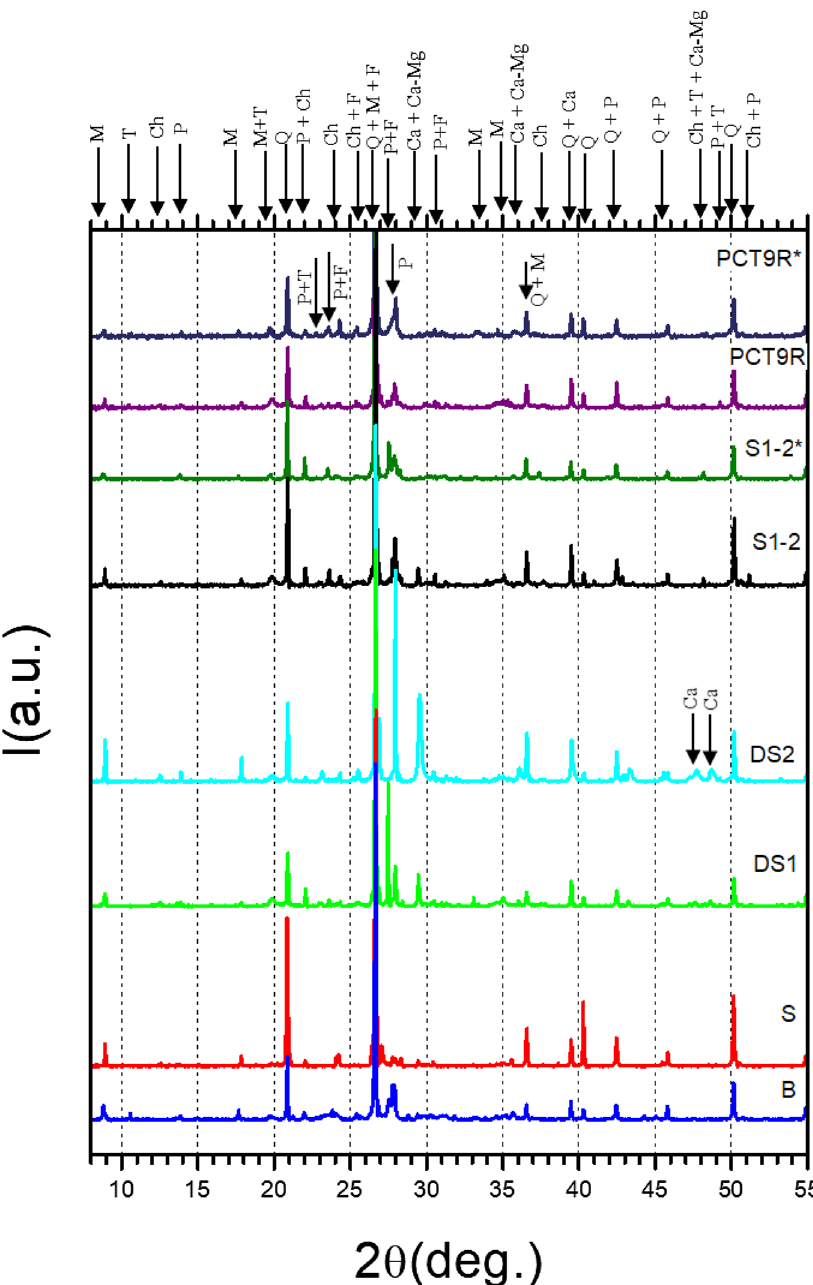
Figure 3. X-ray powder diffraction patterns of burnt (B) and mud (S1–2) bricks, sand (S) and raw soils (DS1, DS2, PCT9R) from Romula. The mineral phases identified are : quartz (Q, CIF: 00-033-1161), chlorite (Ch, CIF: 01-087-2496), mica (M, CIF: 01-074-1107), K-feldspar (F, 00-010-0353), plagioclase (P, CIF: 01-079-1148), Tschermakite (T, CIF: 04-012-1305), calcite magnesian (Ca–Mg carbonate, CIF: 00-043-0697) and calcite (Ca carbonate, CIF: 04-008-0198). Note: (asterisk)—powder samples ignited at 880 °C in air with a heating rate of 200 °C/h, and a dwell time of 1 h. For details of identified minerals see Supplementary material Table